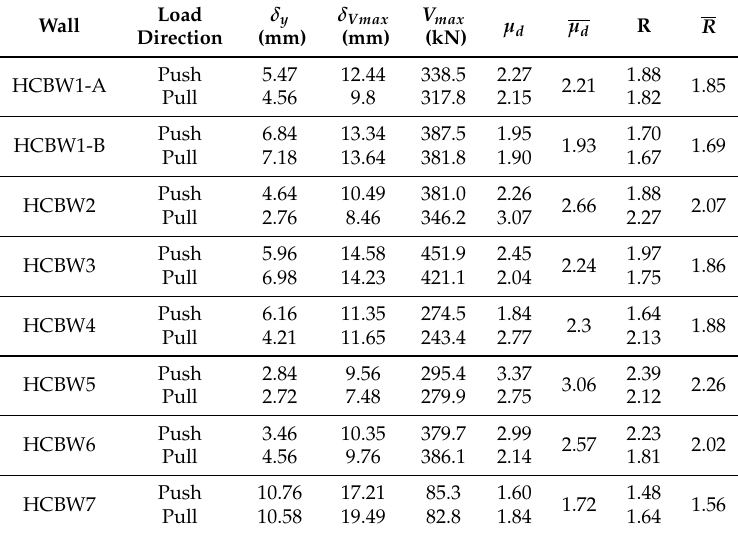
Table 5. Parameters of idealized envelopes, ductility, and R